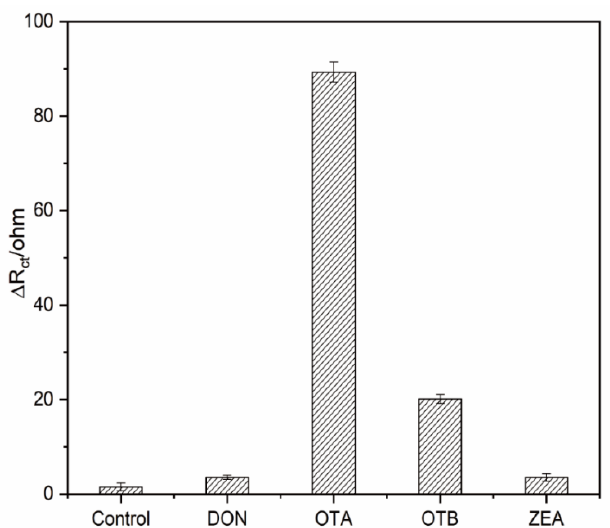
Figure 7. The specificity of the aptasensing system against OTA, ochratoxin B (OTB), deoxynivalenol (DON), and zearalenone (ZEA).